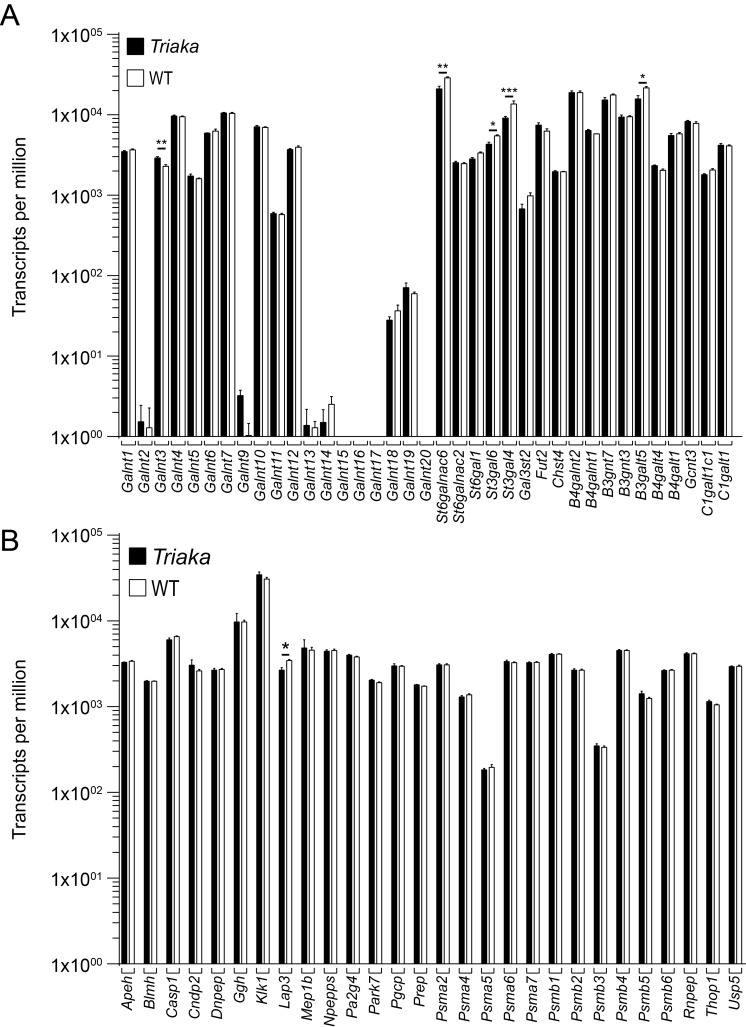
Expression analysis of selected genes with known function for post-translational modification of intestinal mucus.RNA sequencing was performed on colonic intestinal epithelial cells (cIECs) from Triaka and WT mice (n = 4 mice per group) to assess expression of the indicated genes involved in (A) glycosylation or (B) proteolytic cleavage of MUC2. Statistics: Benjamini-Hochberg adjusted p-values from test for differential gene expression.